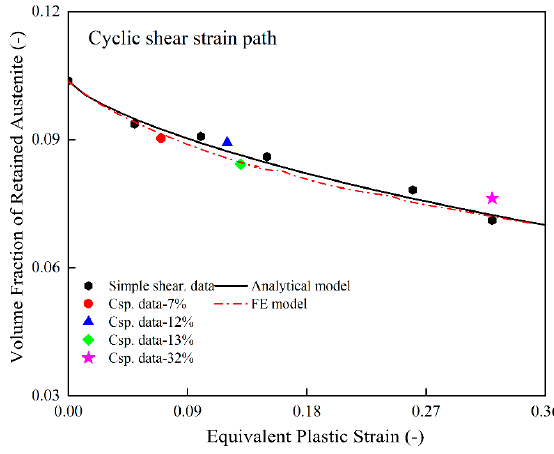
Figure 17. Evolution of retained austenite with EPS during cyclic shear strain loading: these include experimental results from tests of retained austenite volume fractions at EPS of 7%, 12%, 13%, and 32%, and predictions of VFRA from analytical model and FE model.